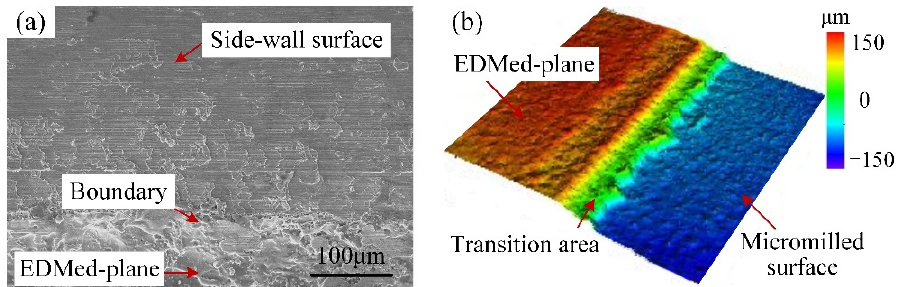
Figure 12. Surface morphology of the bottom boundary of side-walls by the self-fabricated PCD cutter. ( a ) 2D morphology; ( b ) 3D